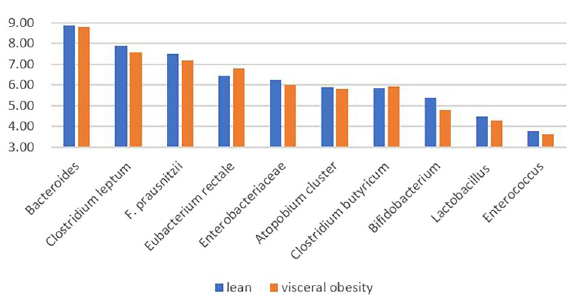
Figure 1. Median counts of ten bacteria in visceral obesity and lean groups. Common logarithm (lg) is used to convert bacterial counts. The median of Bifidobacterium in visceral obesity was 4.78. The median of Bifidobacterium in lean group was 5.36. The difference between two groups was statistically significant (P < 0.05).